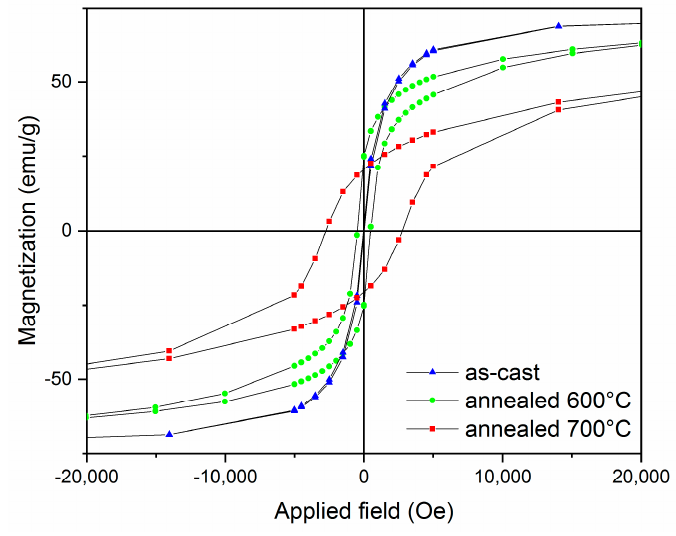
Figure 7. Hysteresis loops for the as-cast and annealed Fe 57 Mn 8 Pt 35 sample.